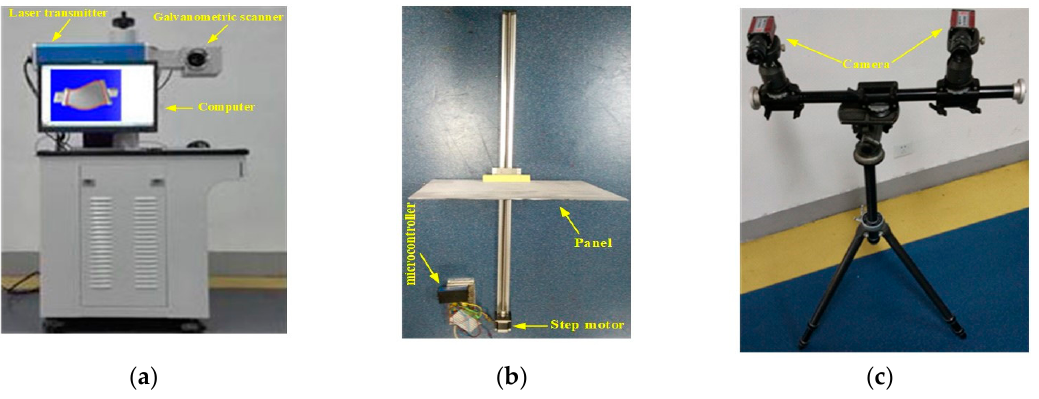
Figure 2. Hardware setup. ( a ) The GLS system. ( b ) The moving mechanism. ( c ) The binocular system.